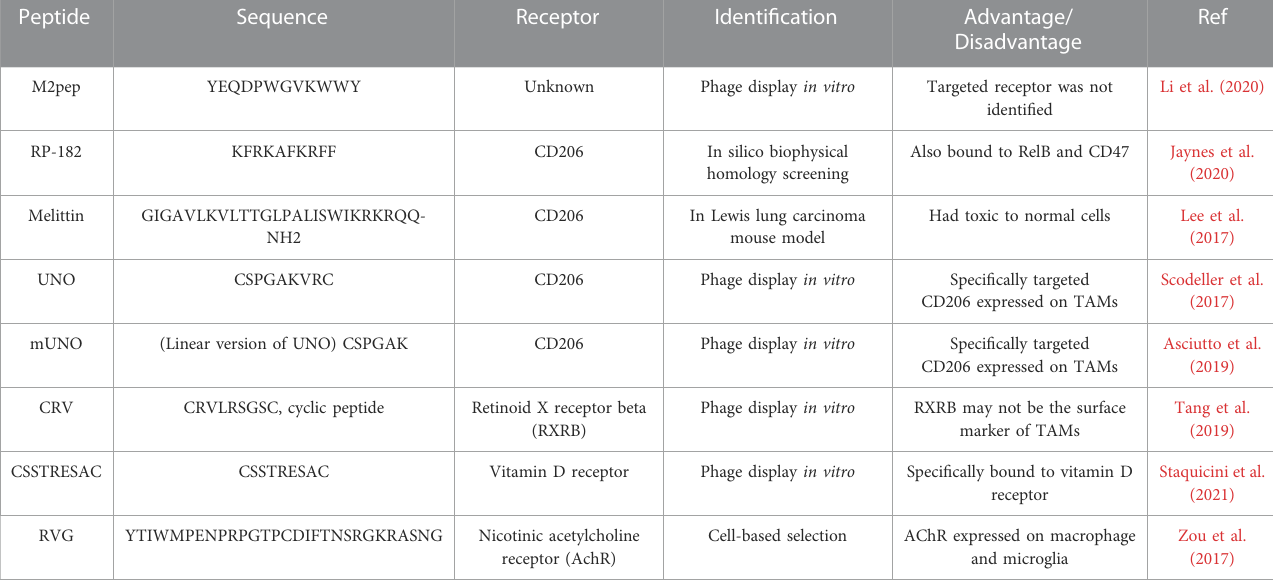
TABLE 1 Peptides targeting TAMs.